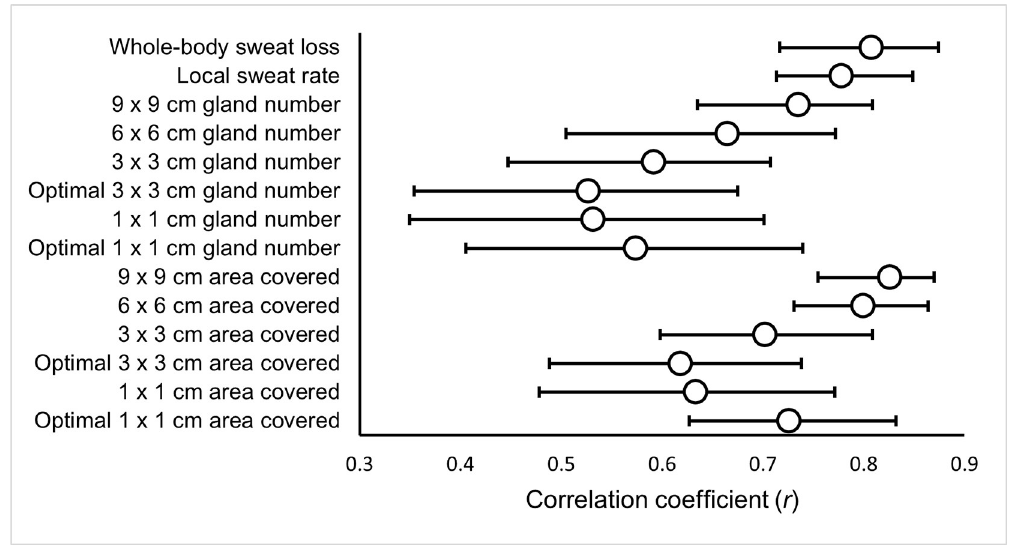
Fig 2. The relationship between absolute heat production (H˙ prod ) and measures of the sweating response.